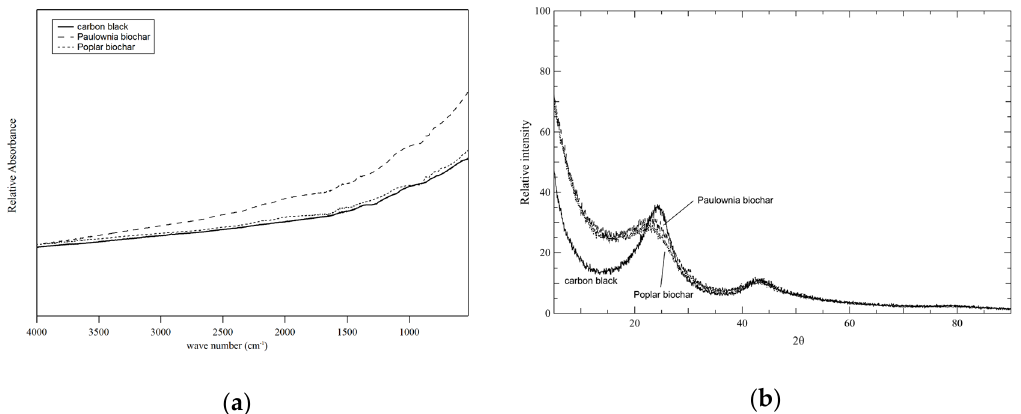
Figure 1. ( a ) Fourier-transform infrared (FTIR) spectra of carbon black, Paulownia biochar, and Poplar biochar. No significant functional group peaks are evident; ( b ) X-ray diffraction spectra of carbon black, Paulownia biochar, and Poplar biochar. Characteristic graphitic d-spacing peaks can be seen at 24° and 43° 2 θ for all three samples.